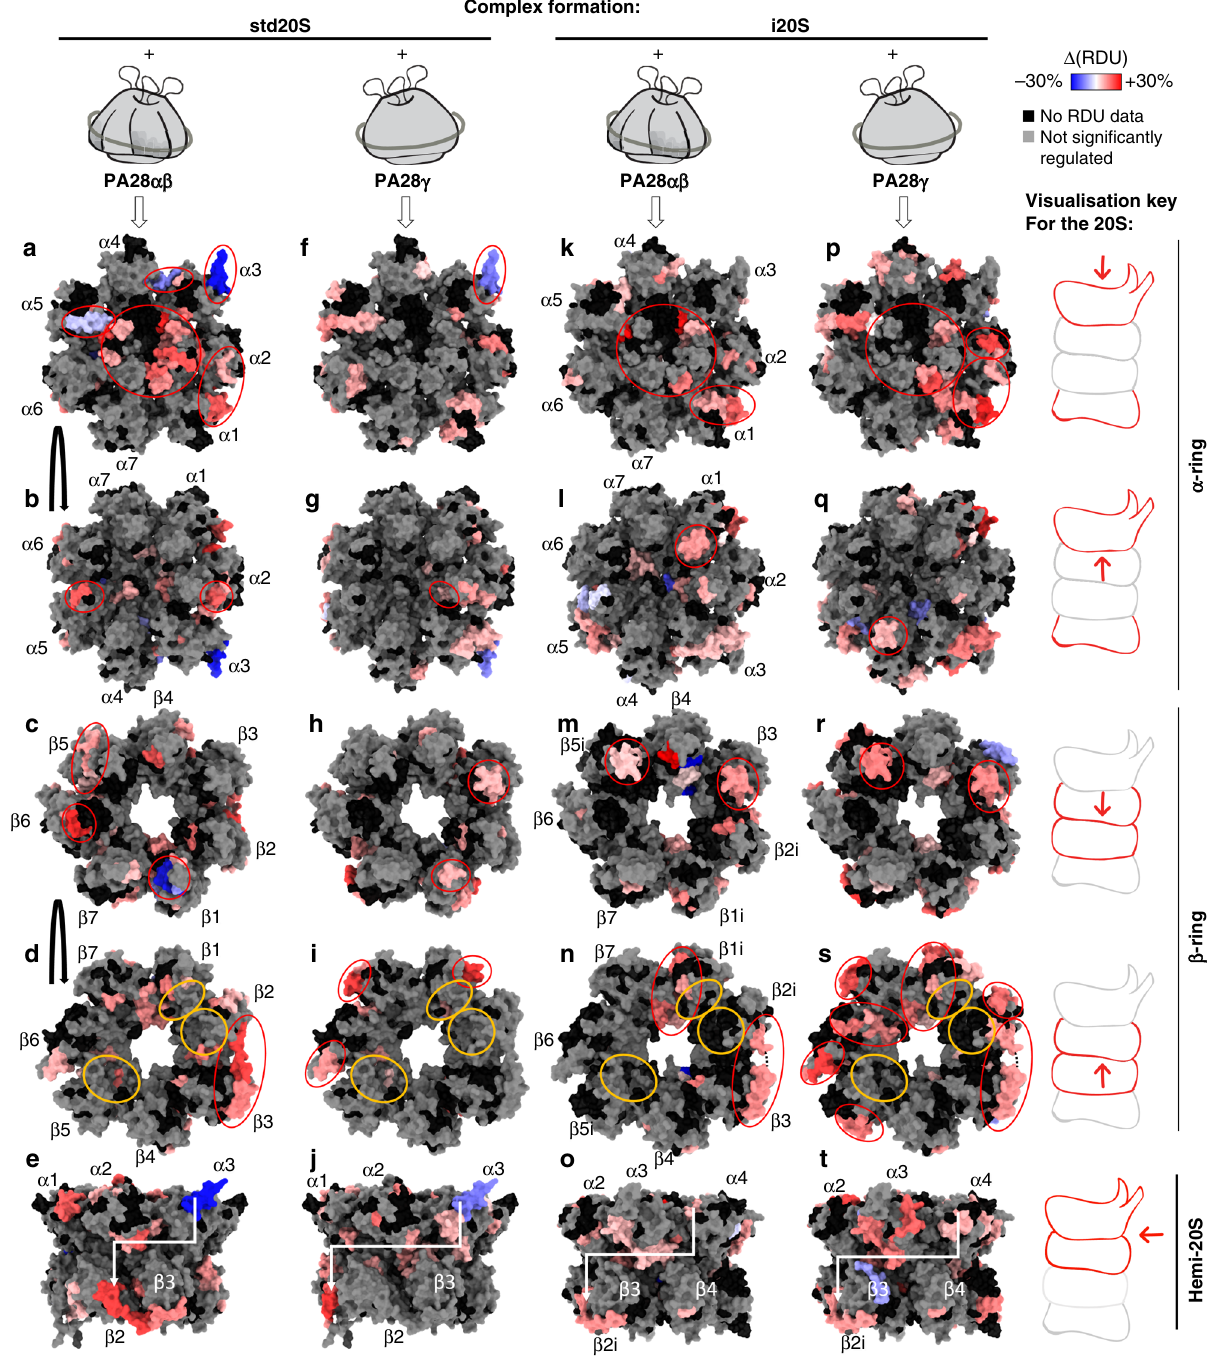
Fig. 7 Catalytic-subunit- and regulator-speci fi city of the outer to inner allosteric changes. Differential relative uptakes accumulated over 30 min deuteration of the 20S proteasomes with and without the PA28 regulators ( Δ (RDU) = RDU 20S/PA28 − RDU 20S ). The regions that were statistically protected or more dynamic upon regulator binding are represented in blue and red, respectively, for the std20S (PDB: 5LE5) and PA28 αβ (PDB: 5MX5) ( a – e ), the std20S and PA28 γ ( f – j ), the i20S (PDB: 6E5B) and PA28 αβ ( k – o ), and the i20S and PA28 γ ( p – t ). Active sites at the β -ring/ β -ring interface are circled in orange. The side views of the hemi-proteasome j/o/t/e show the α -ring and β -ring interface. Residues in gray were not considered signi fi cantly different according to the statistical thresholds presented in Fig. 1c. Residues with no RDU information in one or both conditions are in black. Δ (RDU) sum of differences of relative deuterium uptake. Regions discussed in the text are circled in red. Missing residues from the C-terminal part of β 2i are represented as a black dotted line in panels n and s . The visualization key on the right indicates the identity and orientation of the structures with the same schematics of the 20S as in Fig.